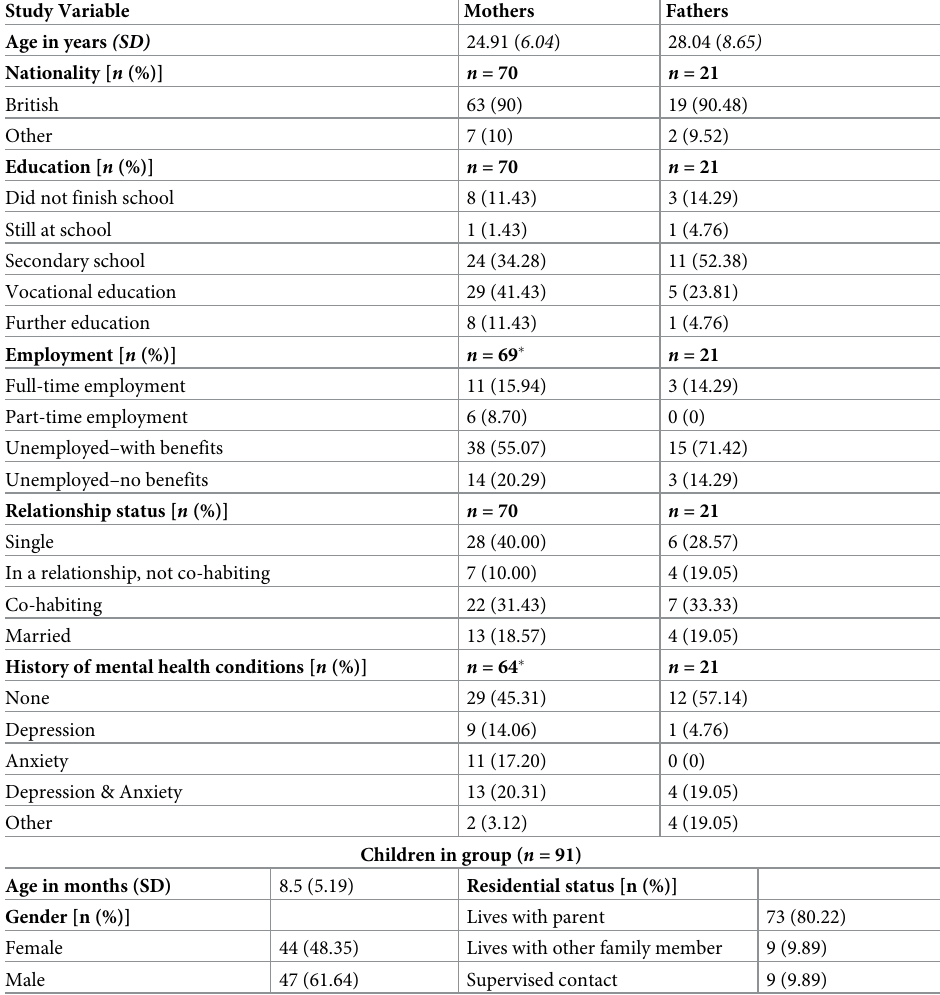
Table 1. Baseline